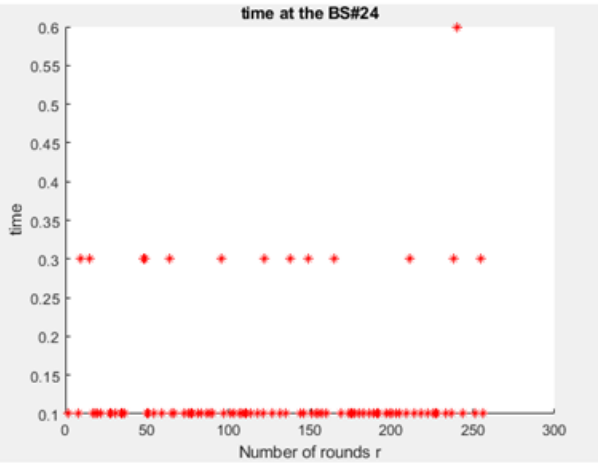
Figure 29. Power profile of advanced node (power consumption for user’s device No. 23).